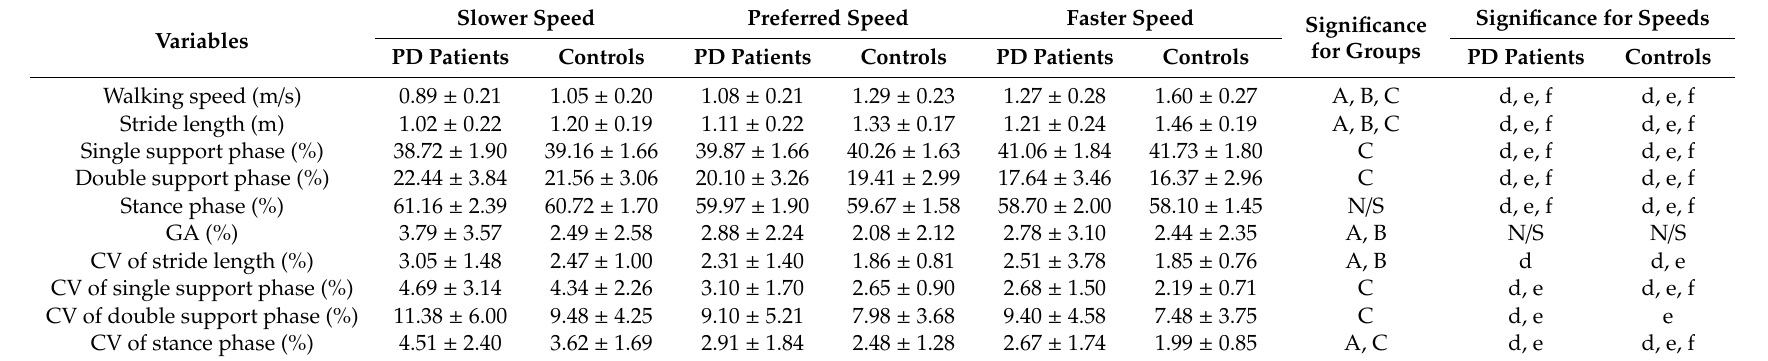
Table 3. Group and speed di ff erences of gait variables in PD patients and